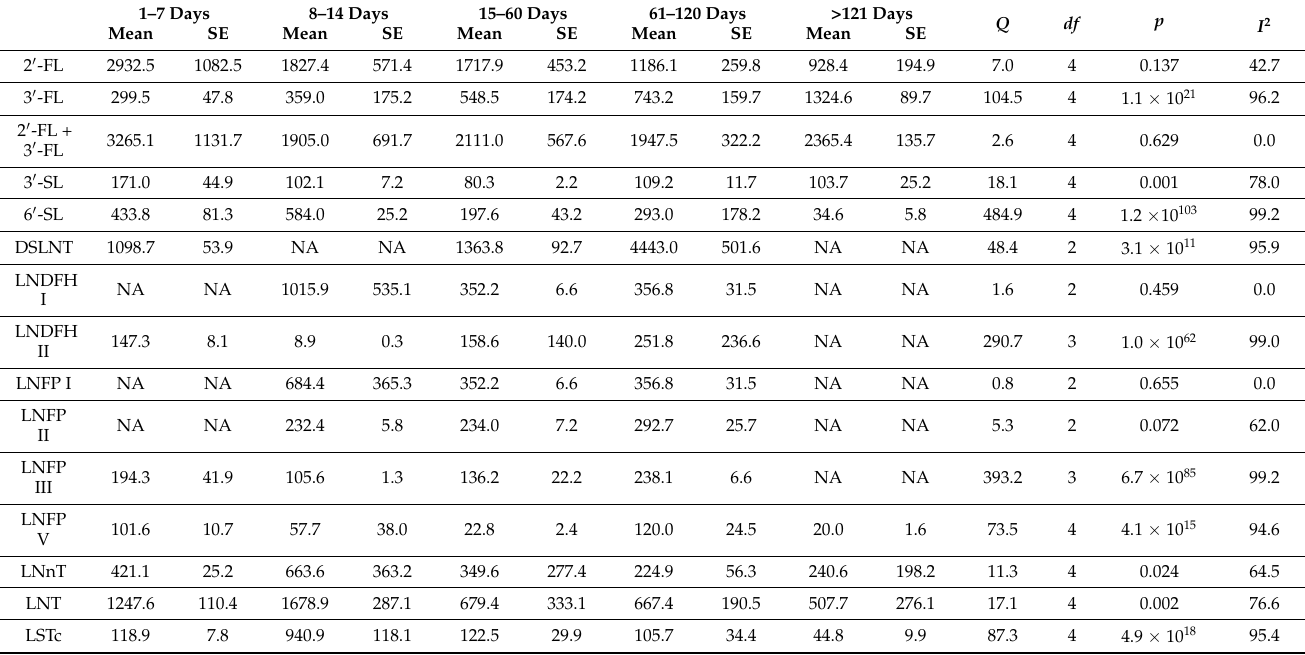
Table 2. Results of subgroup heterogeneity analysis.